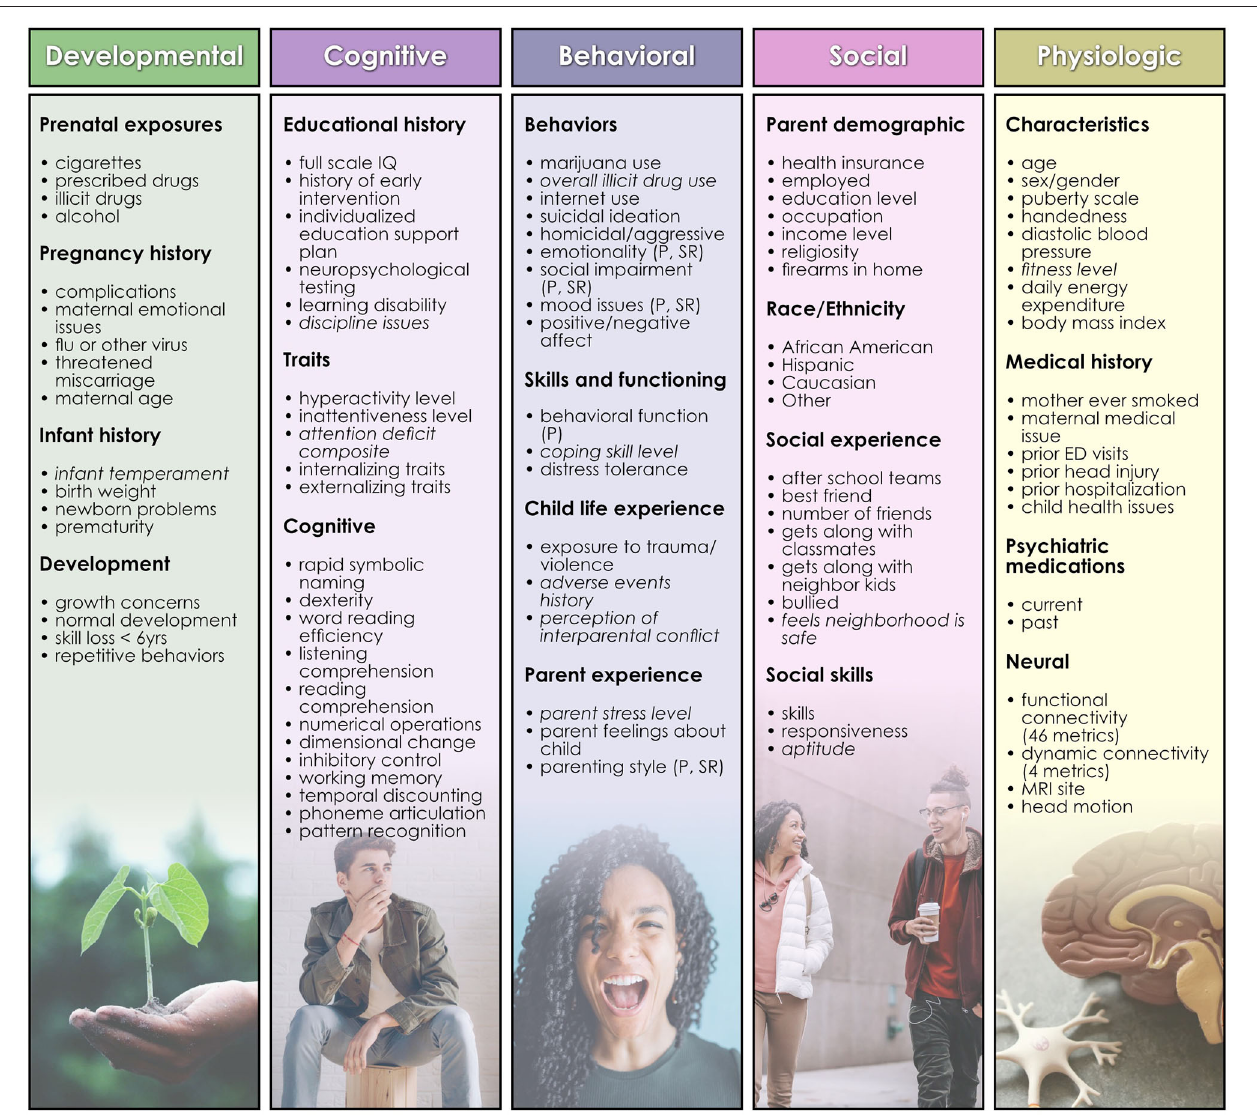
FIGURE 1 | Features used in predictive analytics. Developmental, cognitive, behavioral, social, and physiologic features used as predictors in analytic experiments are shown, organized by type. Terms in italics are those for which feature agglomeration was applied to generate a summative metric. A list of the names of underlying assessments used to generate each feature and further descriptions of features may be inspected in Supplementary Table 1 .